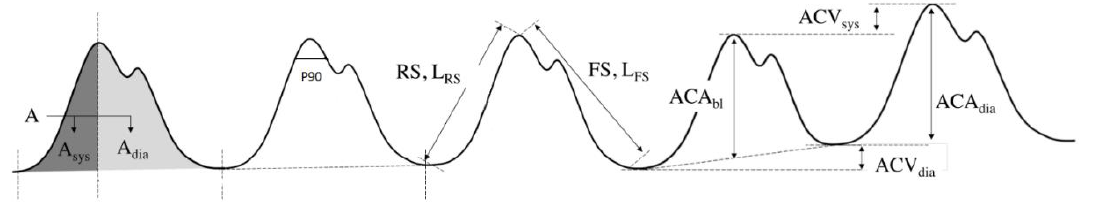
Figure 4. Graphical representation of the parameters extracted with a morphological analysis of the PPG signal. Adapted from: [40]. PPG signal. Adapted from: